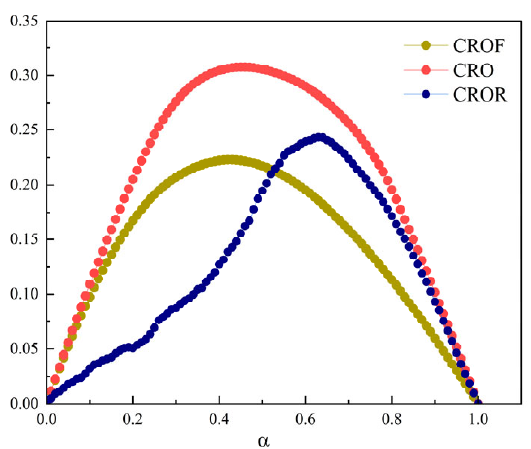
Figure 5. The relationship between complementary indicators and photovoltaic capacity ratio.